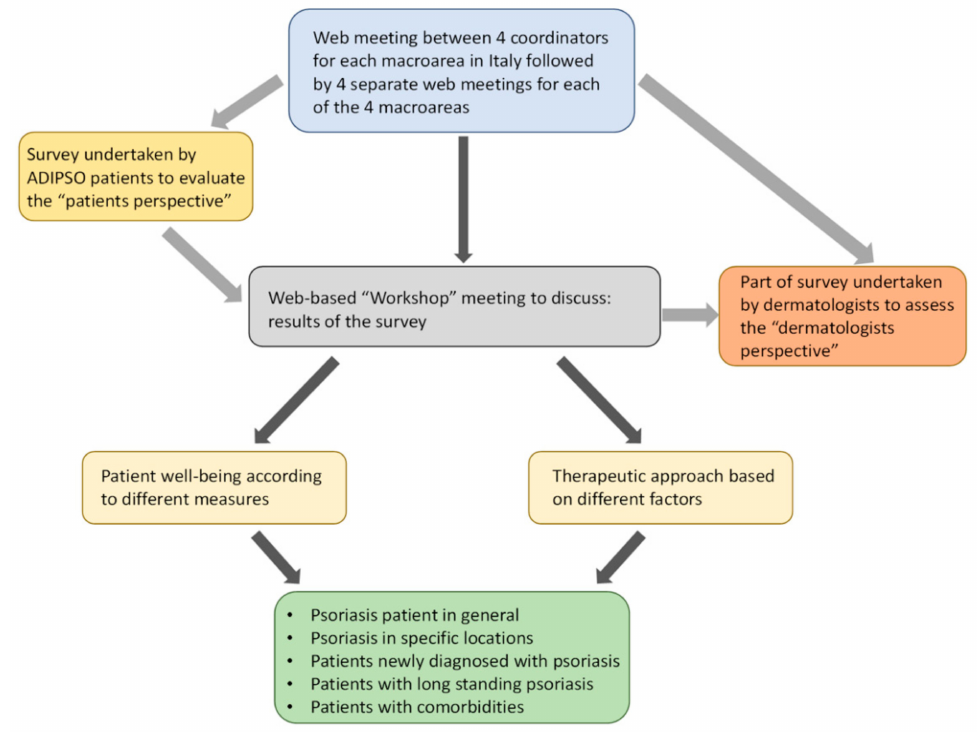
Figure 1. Flow chart of different stages undertaken before and during implementation of the online patient